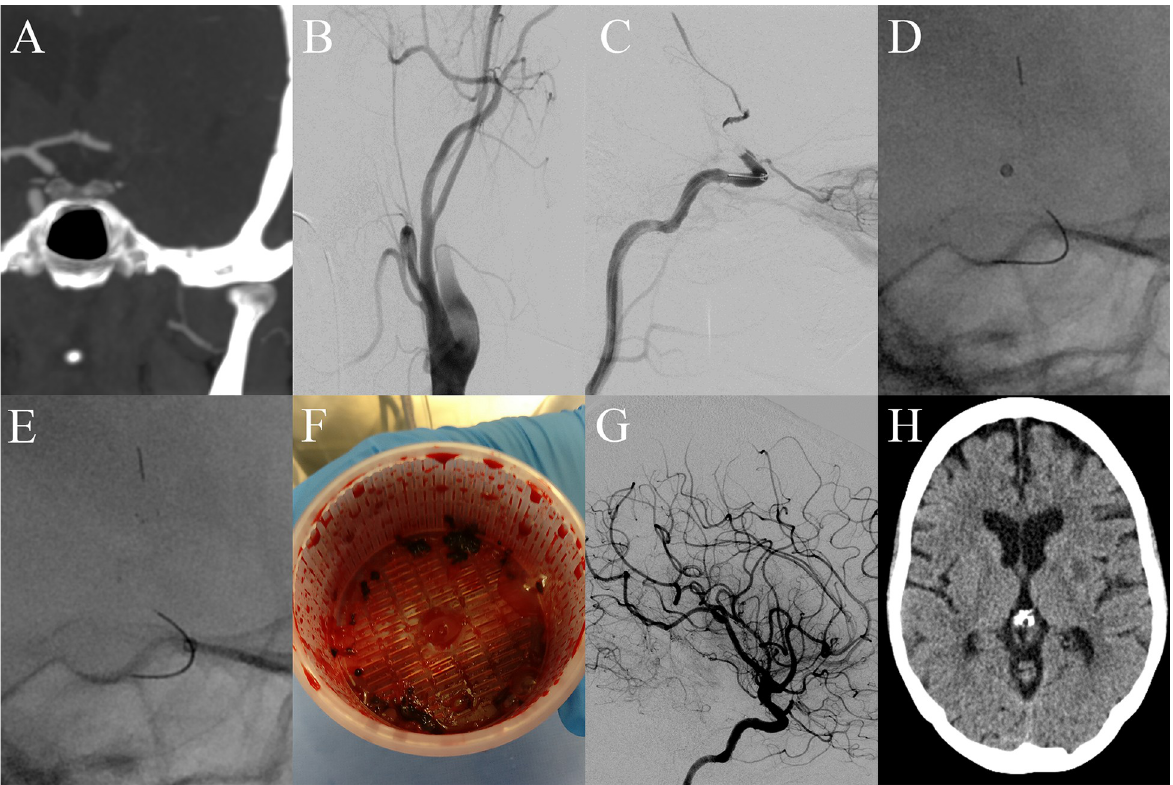
Fig 1. Endovascular treatment with mSAVE. A, CT-angiography (coronal view) of a patient suffering from a distal occlusion of the internal carotid artery (ICA) on the left site. B, First angiogram demonstrating extracranial pseudo-occlusion of the ICA. C, Positioning of a stent retriever in the distal ICA and proximal M1 segment with antegrade flow via the deployed stent retriever. D, The aspiration catheter is connected to an activated pump and advanced to the proximal face of the clot until vacuum is achieved. E, The aspiration catheter is then retrieved along the wire of the stent retriever without moving the stent retriever itself in order to reduce thrombus mass and subsequently advanced to the occlusion site after vacuum is lost. F, The pump canister is showing massive amount of clot prior to embolectomy. G, After performing one attempt of SAVE maneuver the intracranial lesion is recanalized and the downstream territory completely reperfused. H, Final computed tomography at discharge demonstrating a small infarction within the basal